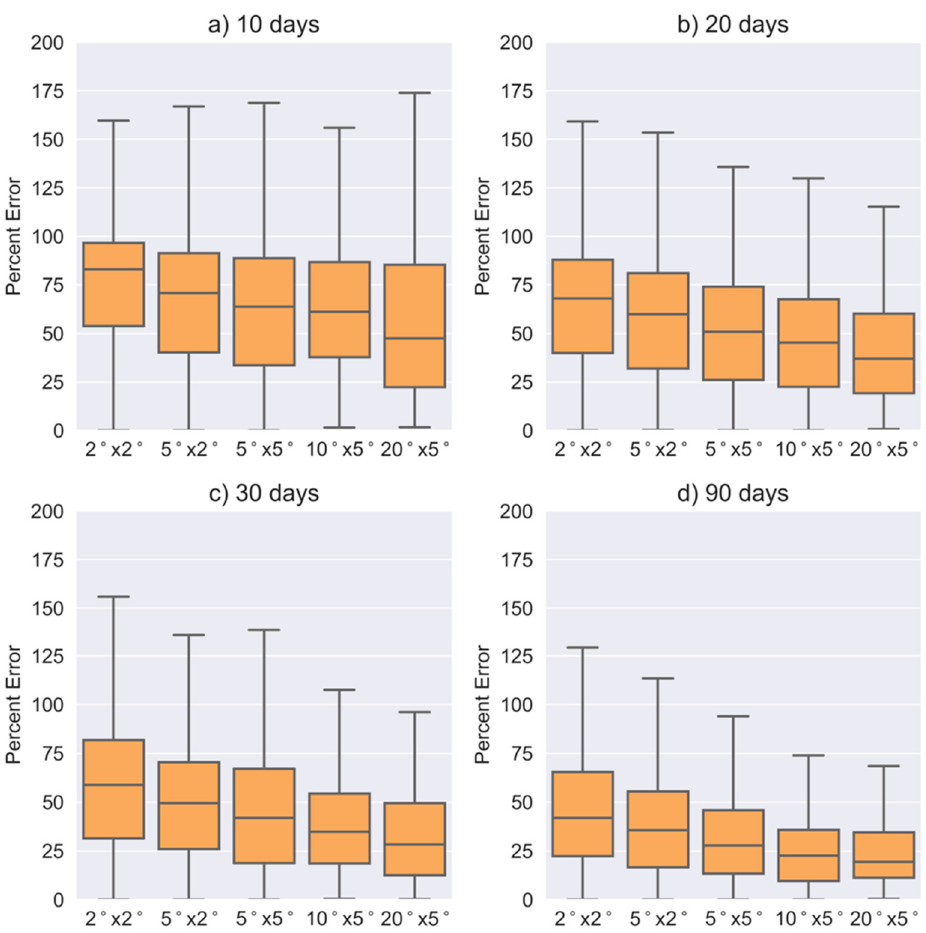
Figure 3. Box and whisker plots describing the PE distributions between complete and subsampled CFDDA precipitation reanalysis estimates at different spatial resolutions for 10 ( a ), 20 ( b ), 30 ( c ) and 90 ( d ) day time periods. The middle line representing the median PE , the box edges represent the first and third quartile, and the edges of the “whiskers” are extended 1.5 times the interquartile range beyond the first and third quartiles. Data beyond the whisker boundaries are not visualized.